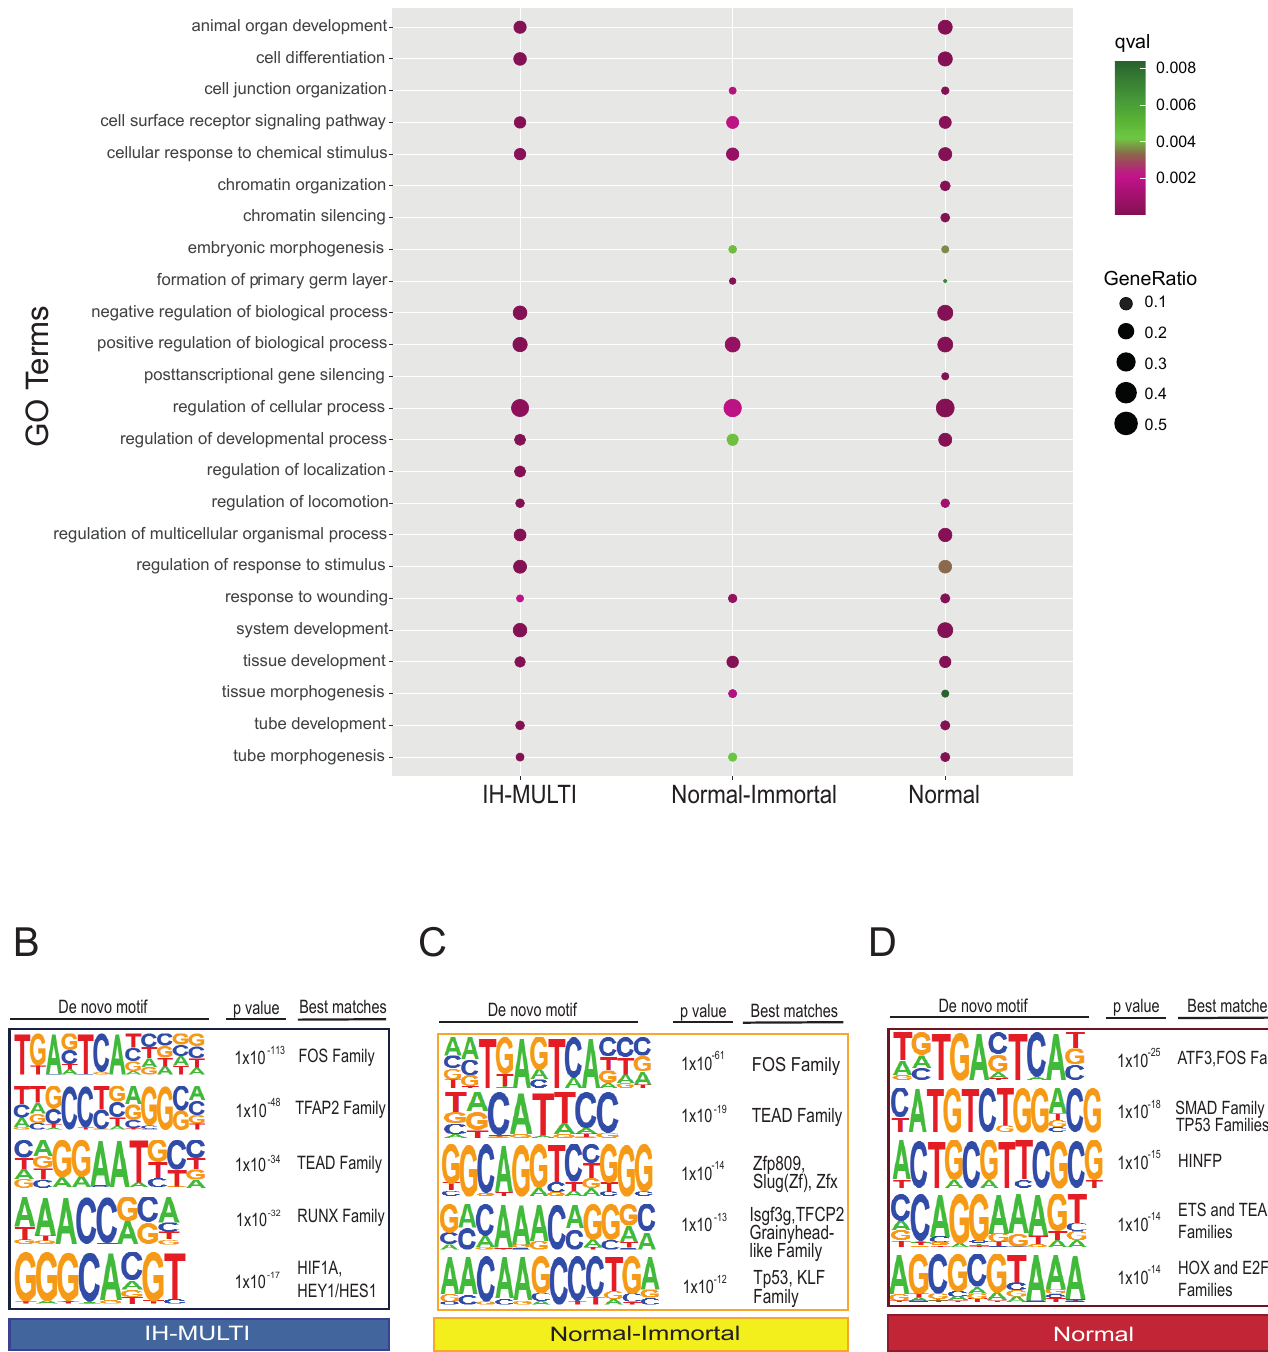
Figure 2. Functional analysis of differential KDM6A peak sets identified across the cell lines. ( A ) Dot plot image displaying the GO term analysis performed for the genes associated with different clusters. ( B – D ) Transcription factor motif analysis performed for IH-MULTI ( B ), normal-immortal ( C ), and normal ( D ) clusters. Up to 3 different transcription factors/transcription factor families are shown with the best motif matching